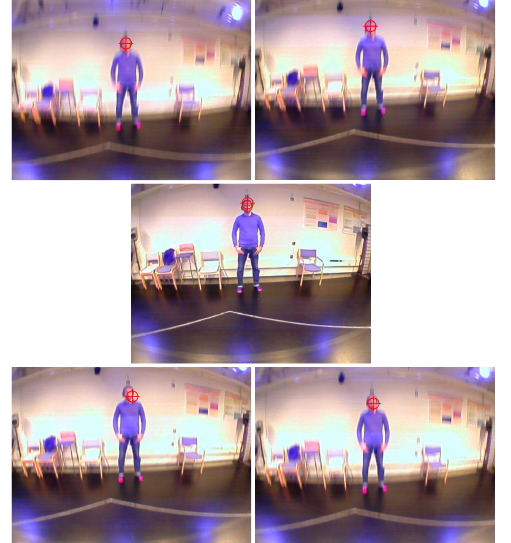
Figure 6. Field camera sequence of the head nod. During the nod, the head (i.e., field camera) moves downwards until the point of most downward displacement (middle picture) while fixing the target (the face of the other person in this case). The correspond- ing time stamp of the picture frame in the middle constitutes the “ground truth data”.